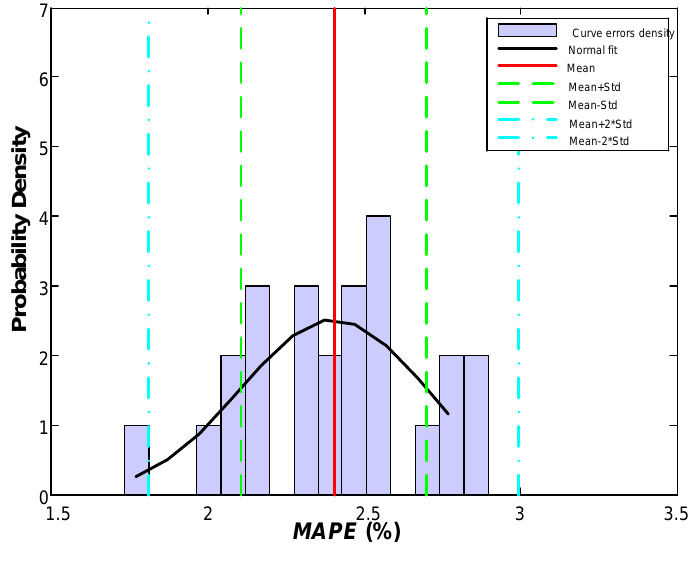
Figure 10. Curve errors per hours. In the x-axis are the errors by Equation (3). In the y-axis are the probability densities.